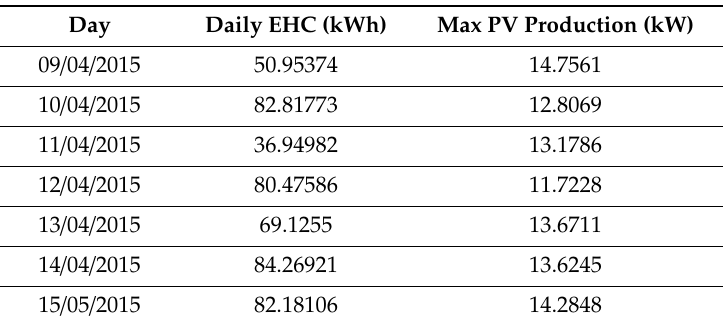
Table 3. Daily EHC and PV maximum production.